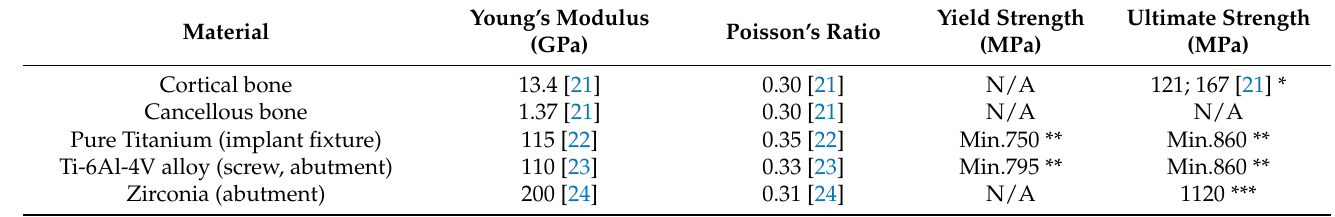
Table 2. Materials used in this study.